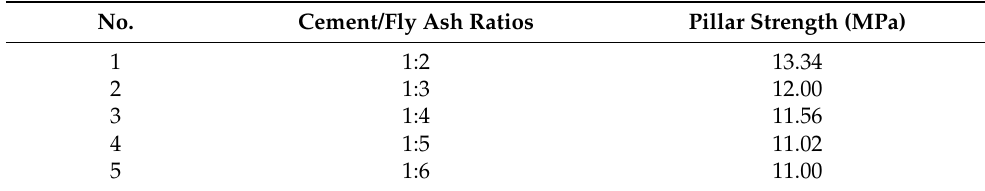
Table 8. Coal pillar strength for different filling material proportioning